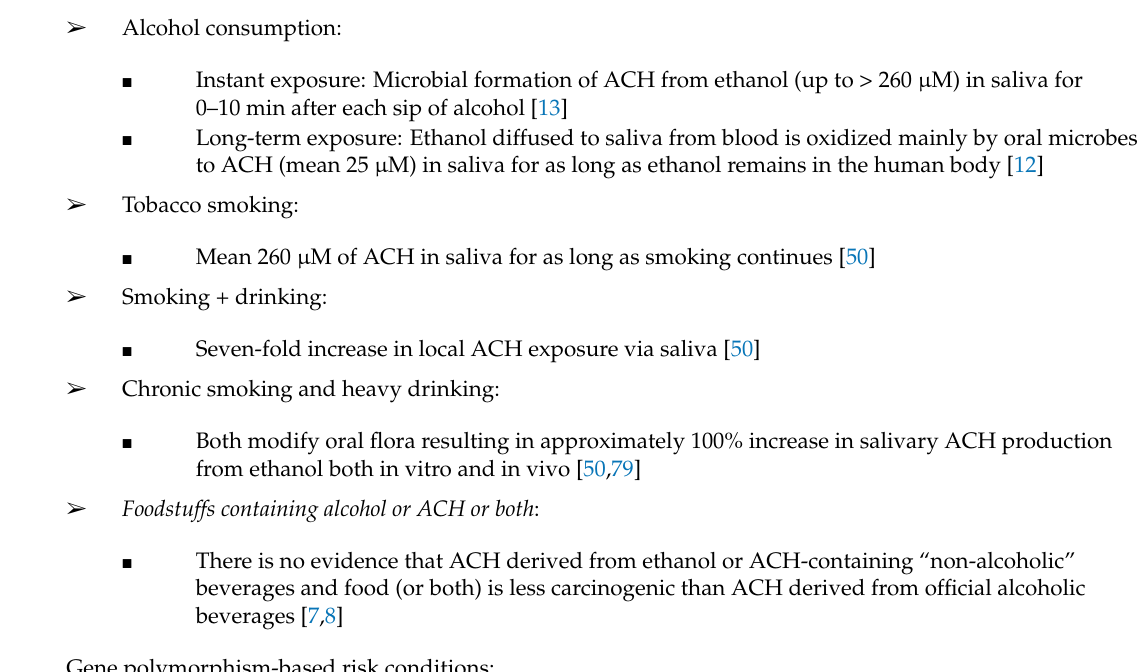
Table 4. Environmental, genetic, disease-based, and iatrogenic risk factors or conditions for upper GI tract cancer and their effect on local acetaldehyde (ACH) exposure via saliva. Without the presence of ethanol or tobacco, salivary ACH levels are under the detection limit (<2 µ M, [12,50]). The estimated concentration range of mutagenicity for ACH is 40–100 µ M